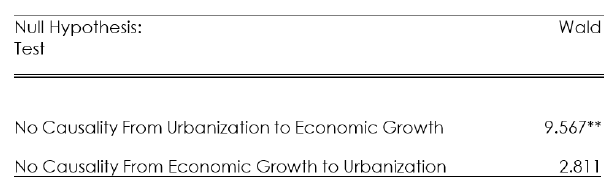
**, indicates significance at 5 %